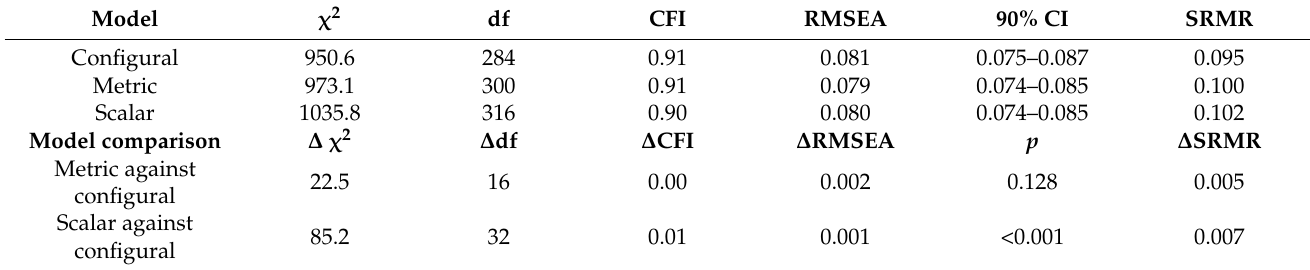
Table A3. The Revised Perceived Locus of Causality in Physical Education Scale (PLOC-R) measure- ment invariance across gender groups ( n =